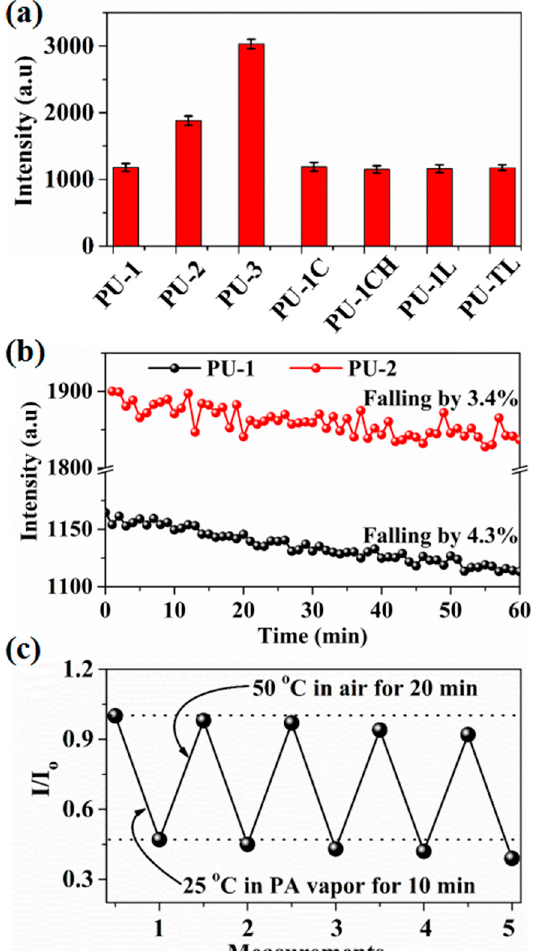
Figure 7. ( a ) Fluorescent homogeneity of 10 test points of fluorescent nanofibrous membranes (error bars represent the standard deviation of 10 test points of fluorescent membranes), ( b ) time stability of PU-1 and PU-2 membranes (relative humidity is 40%), ( c ) the normalized fluorescence recovery cycles of PU-1C membrane.